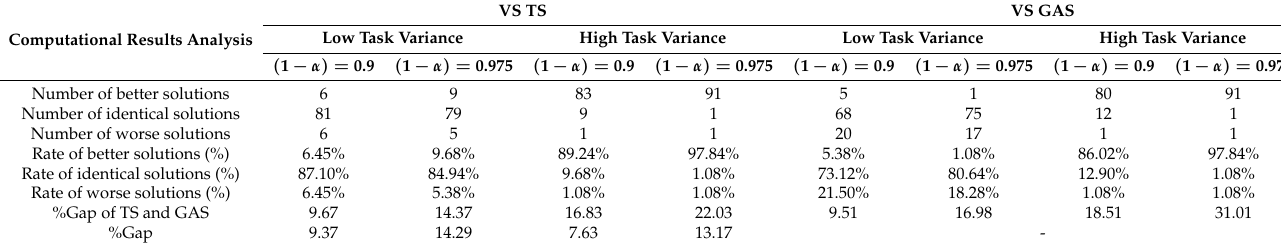
Table 7. Analysis of the computational results.